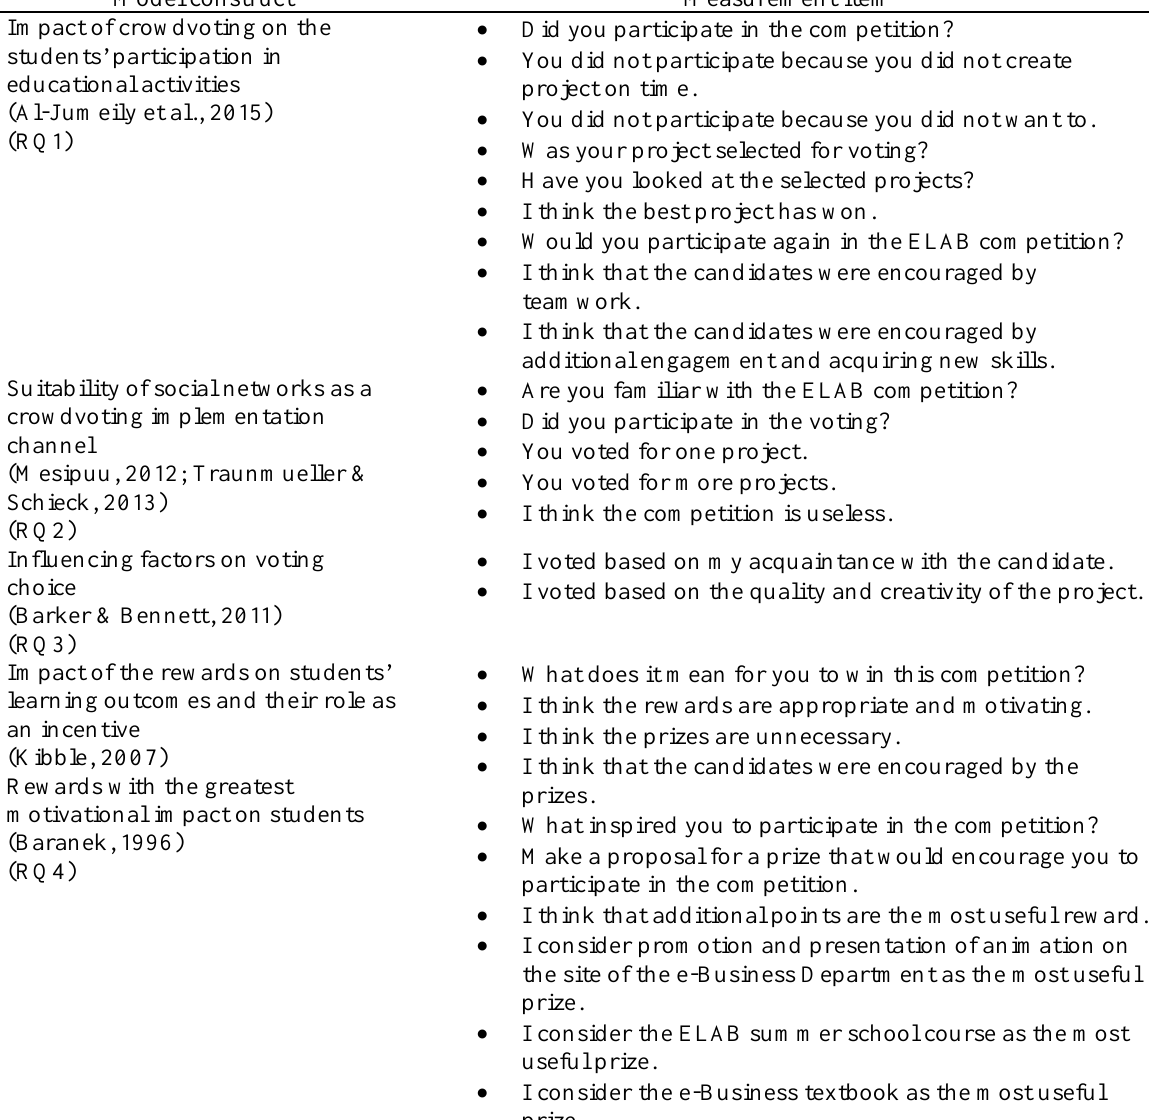
Table 1 Measurement Items Included in Questionnaire Model construct Measurement